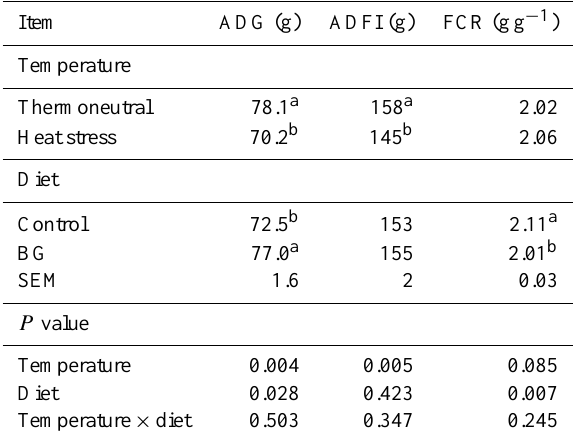
Table 2. Effect of propolis (bee glue; BG) on growth performance of broiler chickens subjected to heat challenge ( n = 6). SEM stands for “standard error of the mean”.